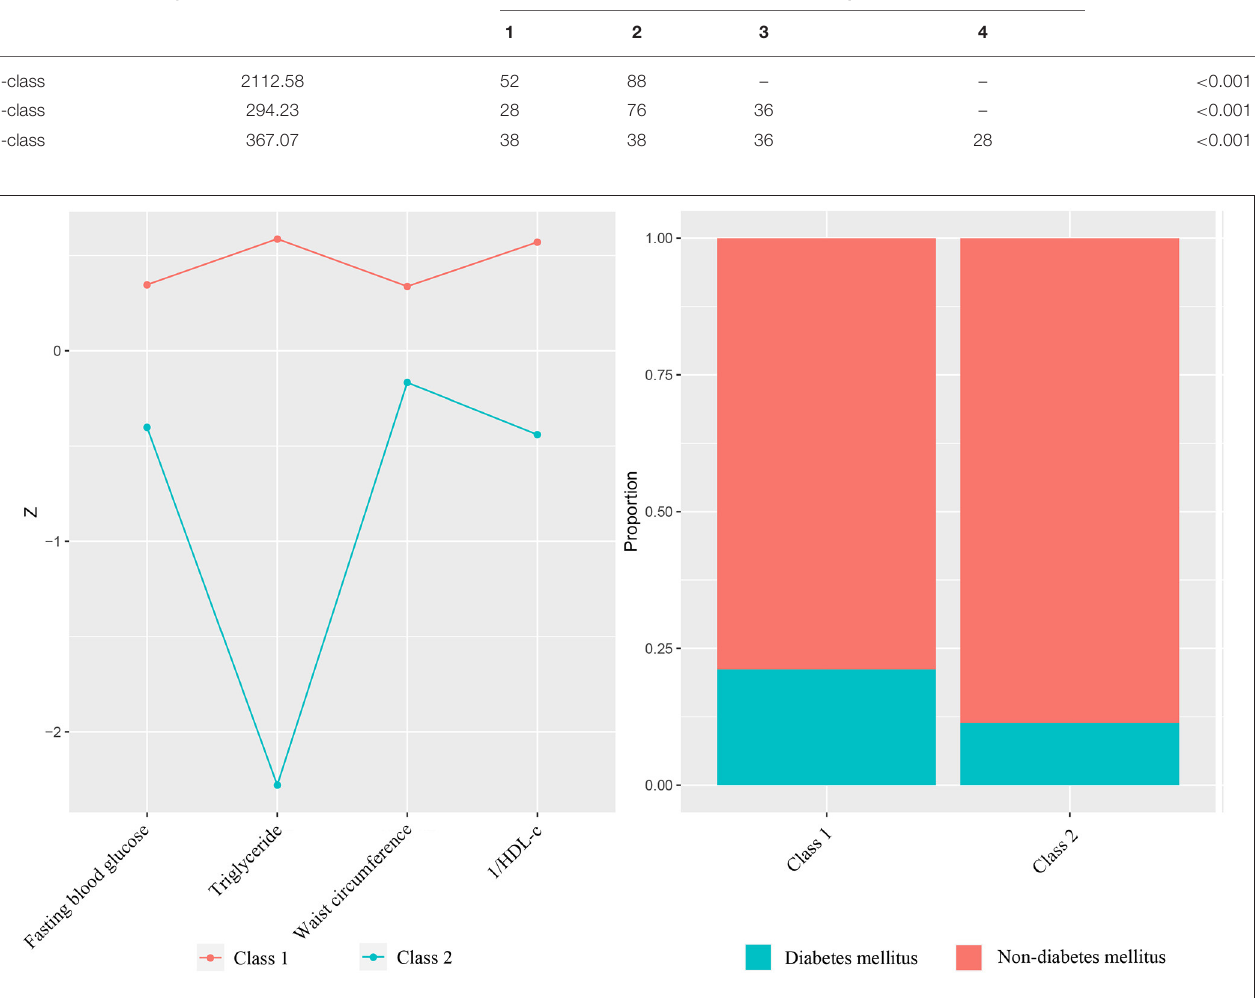
FIGURE 2 | Differences of classified variables by the two-class